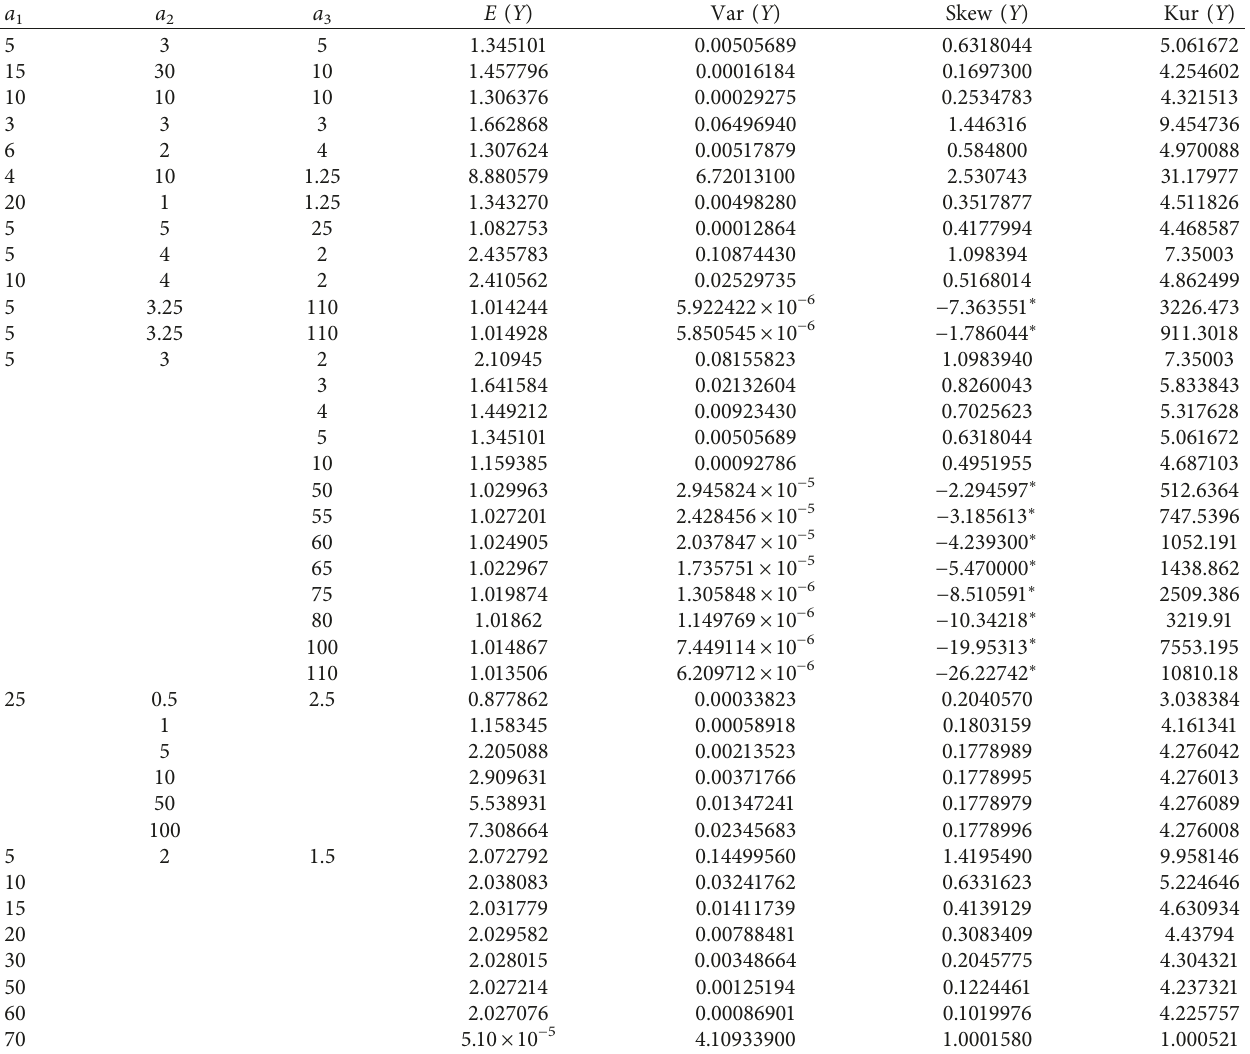
Table 2: E ( X ), Var ( X ), Skew ( Y ), and Kur ( Y ) of the GOLLRW